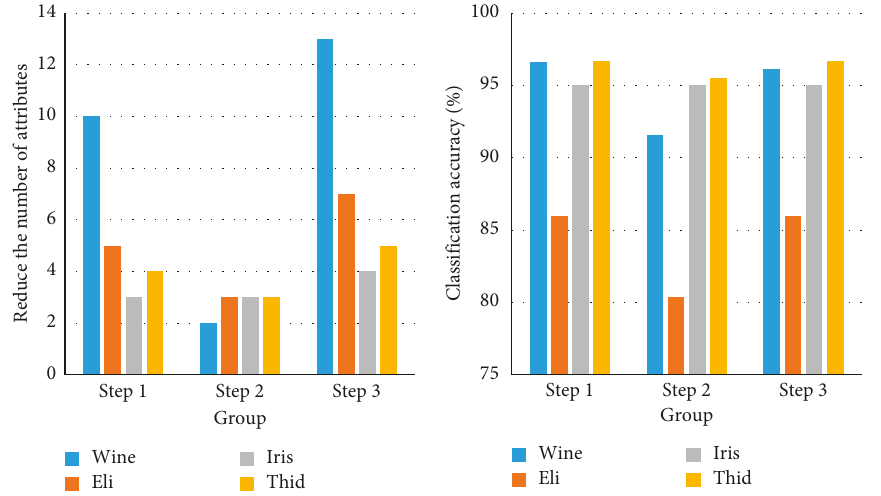
Figure 6: Support vector machine recognition